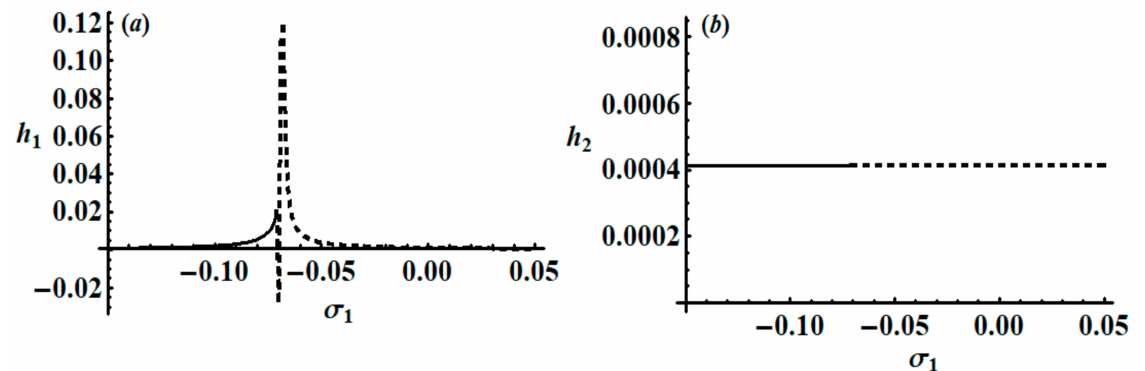
Figure 10. Sketches of the variation of modulation amplitudes h j ( j = 1,2 ) with the detuning parameter σ 1 at σ 2 = −